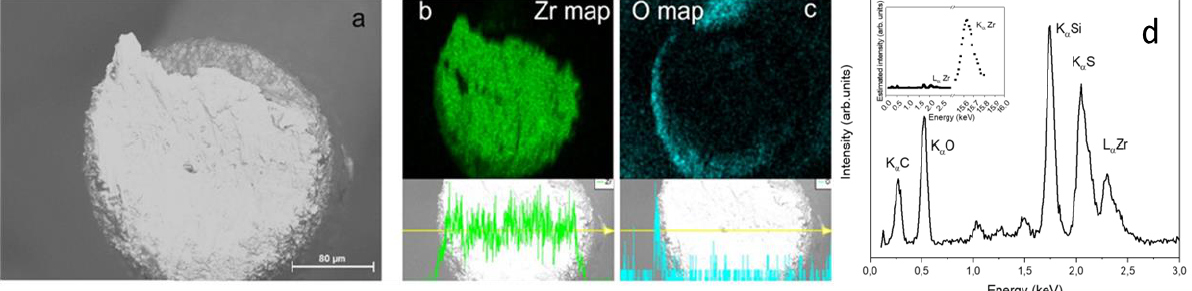
Figure 7. ( a ) Cross-section of the wire; ( b ) Zr map (upper) and profile (lower), showing the uniformity of Zr distribution; ( c ) O map (upper) and profile (lower), the oxygen signal is significant only at the outer surface of the wire (the lack of O signal at the right border is a shadow effect due to the topography of the sample and its orientation respect to the detector); ( d ) EDX spectrum recorded with an accelerating voltage of 10 keV on the surface of the wire. The inset shows an estimation of the intensity of the Zr K α line relative to the peaks shown in the main graph.